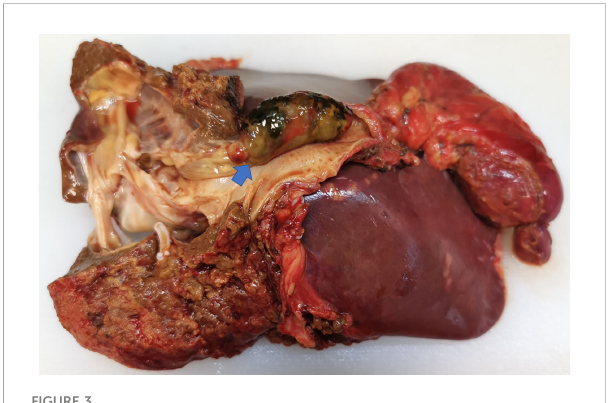
FIGURE 3 Macroscopic image of the specimen with the tumor within the common bile